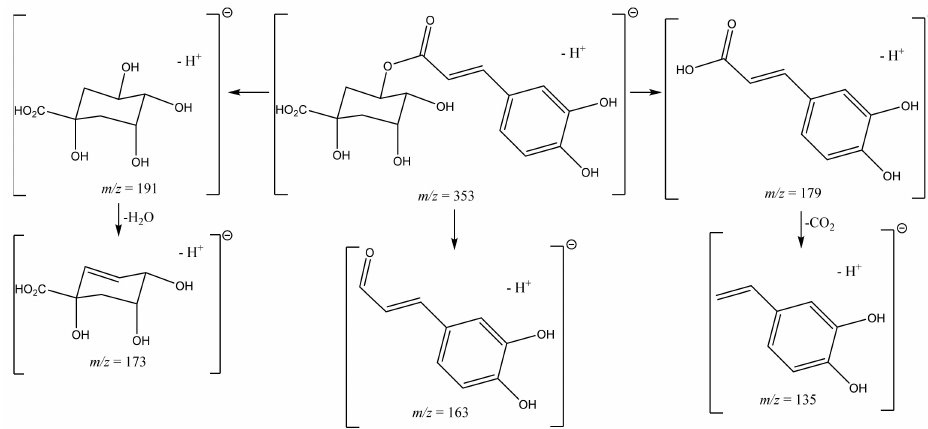
Figure 2. 5- O -CQA main fragments.